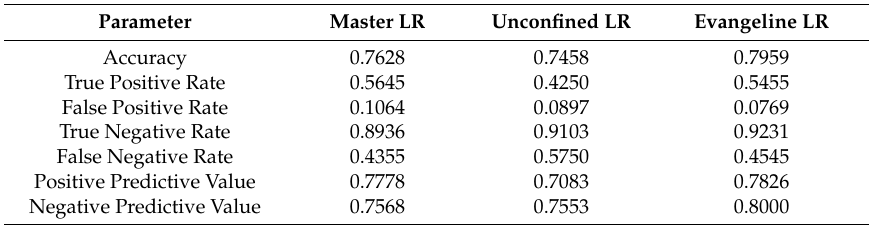
Figure 5. Receiver operating characteristics (ROC) curve for the master LR model. Table 2. Comparison of model ROC performance characteristics.